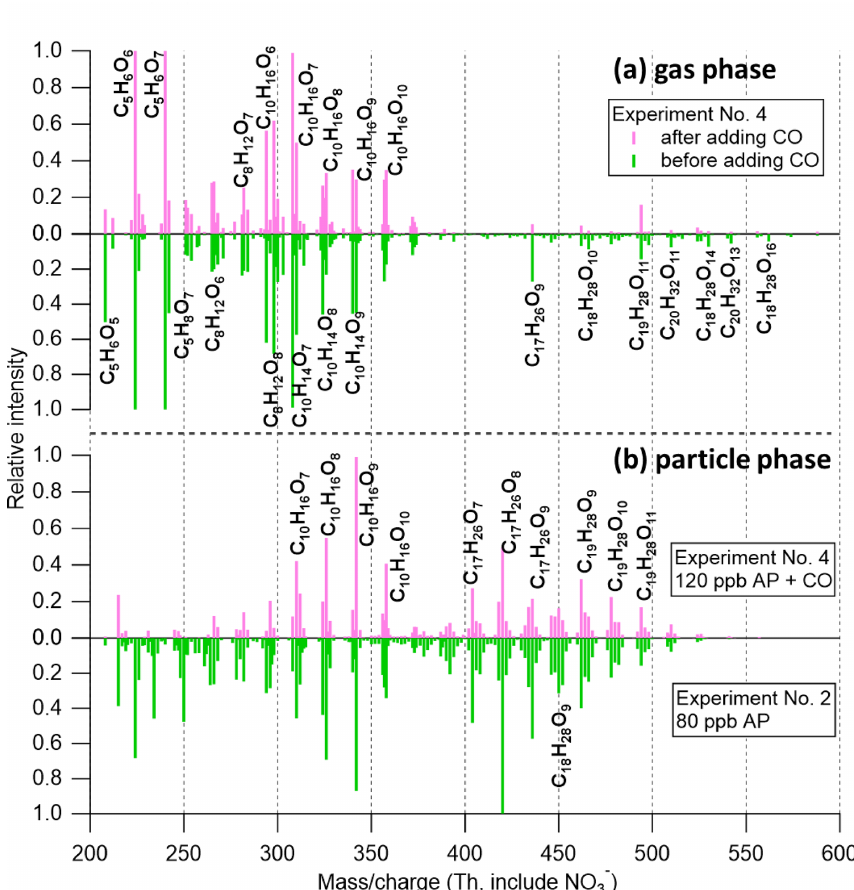
Figure 5. Mass spectra of (a) gas-phase (30min average) measurements before (green) and after (pink) adding 100ppm CO in experiment no. 4 (input flow concentration as 120ppb α -pinene and 33ppb O 3 ), normalized to (C 10 H 14 O 7 )NO 3 at m/z 308 with m/z 224 and m/z 240 off the scale, and (b) particle-phase (60min average) measurements with (pink) and without (green) CO, normalized to (C 10 H 16 O 9 )NO 3 at m/z 342 and (C 17 H 26 O 8 )NO 3 at m/z 420, respectively. Note that the oxidation rate of α -pinene decreased to about half due to the decreased OH oxidation after adding CO (assuming the OH yield to be ∼ 0 . 8 from ozonolysis of α -pinene). Therefore, experiment no. 2 (80ppb α -pinene) was chosen for the particle-phase comparison because of comparable SOA